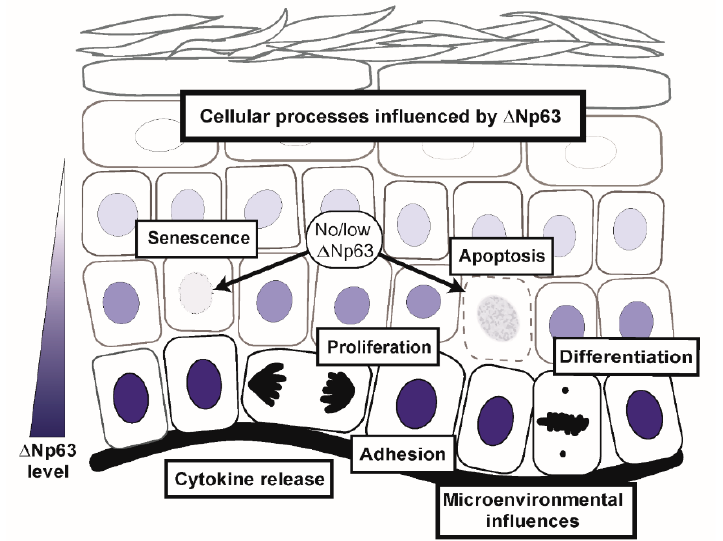
Figure 3. ∆ Np63 α regulates cell intrinsic and extrinsic biological processes involved in normal epidermal morphogenesis and homeostasis. In cancer, amplification of p63 leads to the hijacking of these processes to support conversion to and progression of the malignant state.